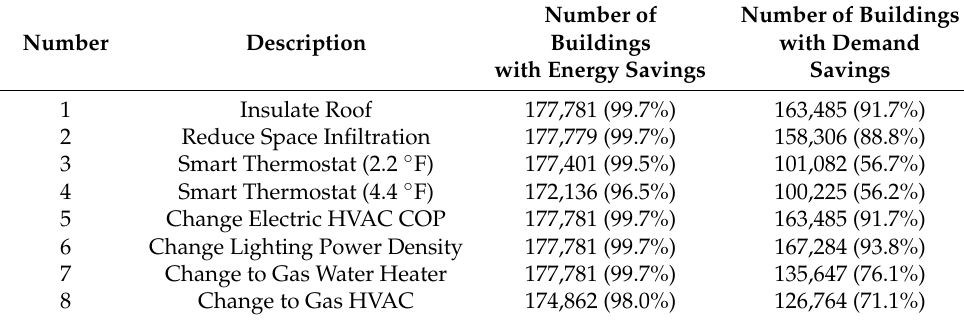
Table 6. Number of buildings/observations of positive energy or demand